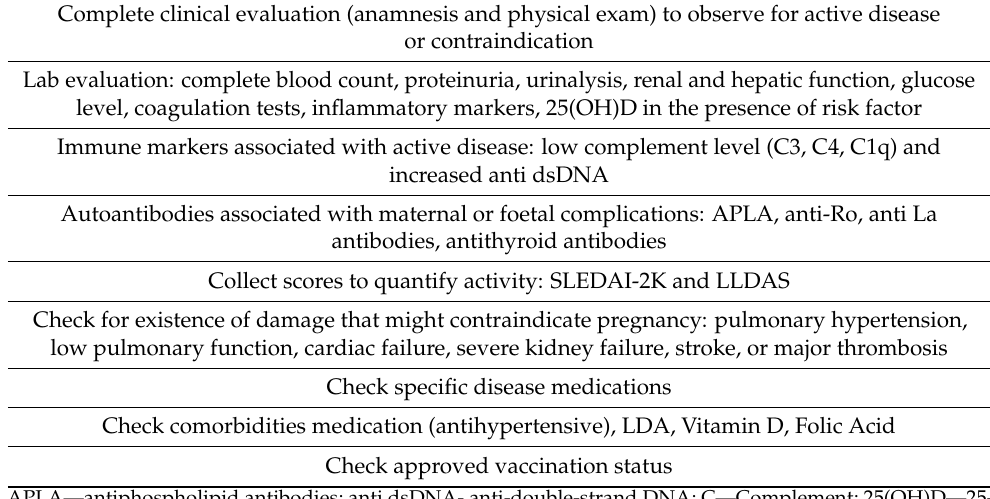
Table 6. Routine evaluation of a SLE patient preparing for pregnancy. Complete clinical evaluation (anamnesis and physical exam) to observe for active disease or